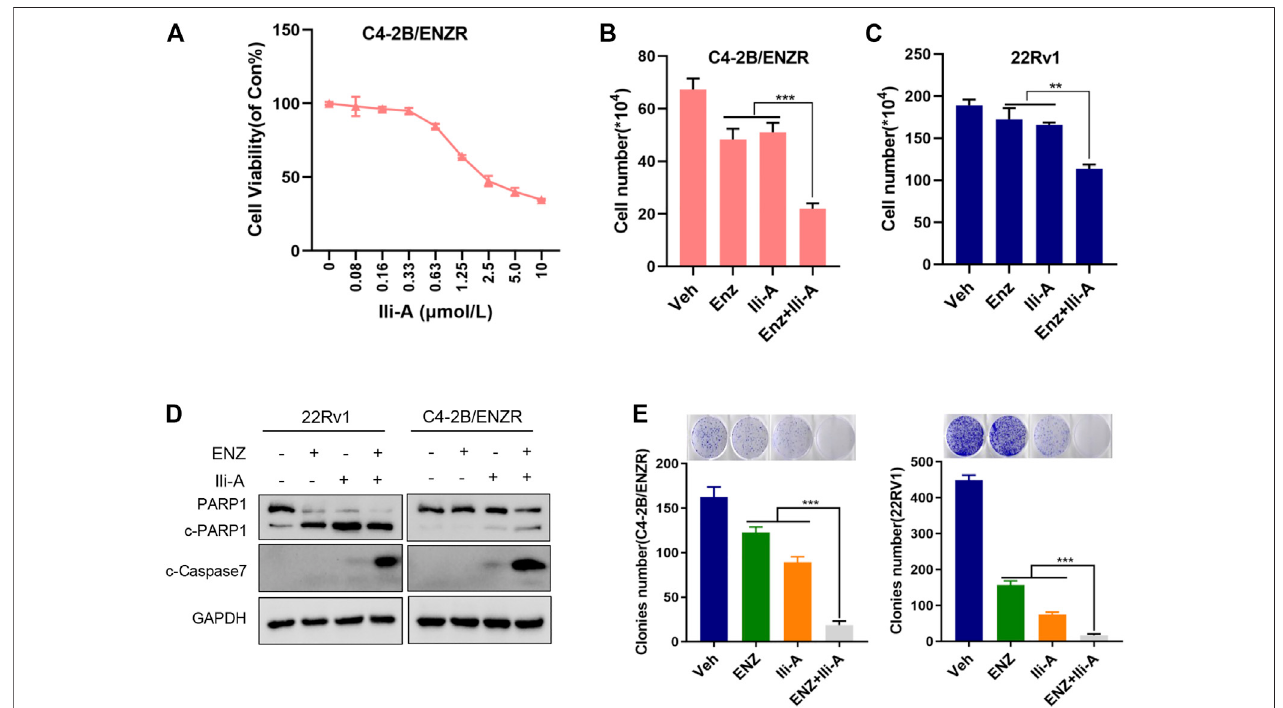
FIGURE5| CotreatmentofIli-Aandenzalutamide(ENZ)suppressescellgrowthandinducesapoptosisinCRPCcells. (A) Cellproliferationwasassessedusingthe CellTiter-Glo assay after 96 h of treatment with Ili-A in C4-2B/ENZR cells at the indicated doses. (B,C) Cell numbers were counted with a cell counter after 96 h of treatment with Ili-A (1.25 μ M), enzalutamide (ENZ; 10 μ M) or Ili-A (1.25 μ M) plus ENZ (10 μ M) in 22Rv1 cells and C4-2B/ENZR cells. (D) Western blots demonstrating apoptoticmarkersfollowingtreatmentwithvehicle, Ili-A(1.25 μ M),enzalutamide(ENZ; 10 μ M) or Ili-A (1.25 μ M) plus ENZ(10 μ M) in 22Rv1 cellsand C4-2B/ENZR cells. (E) Cell proliferation as assessed using a colony-formation assay after 12 days of treatment with Ili-A (1.25 μ M), enzalutamide (ENZ; 10 μ M) or Ili-A (1.25 μ M) plus ENZ (10 μ M) in 22Rv1 cells and C4-2B/ENZR cells.